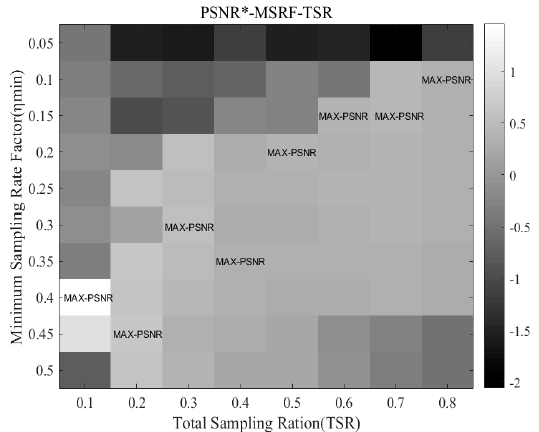
Figure 5. Correlation between PSNR * , MSRF, and TSR of test image Lena.